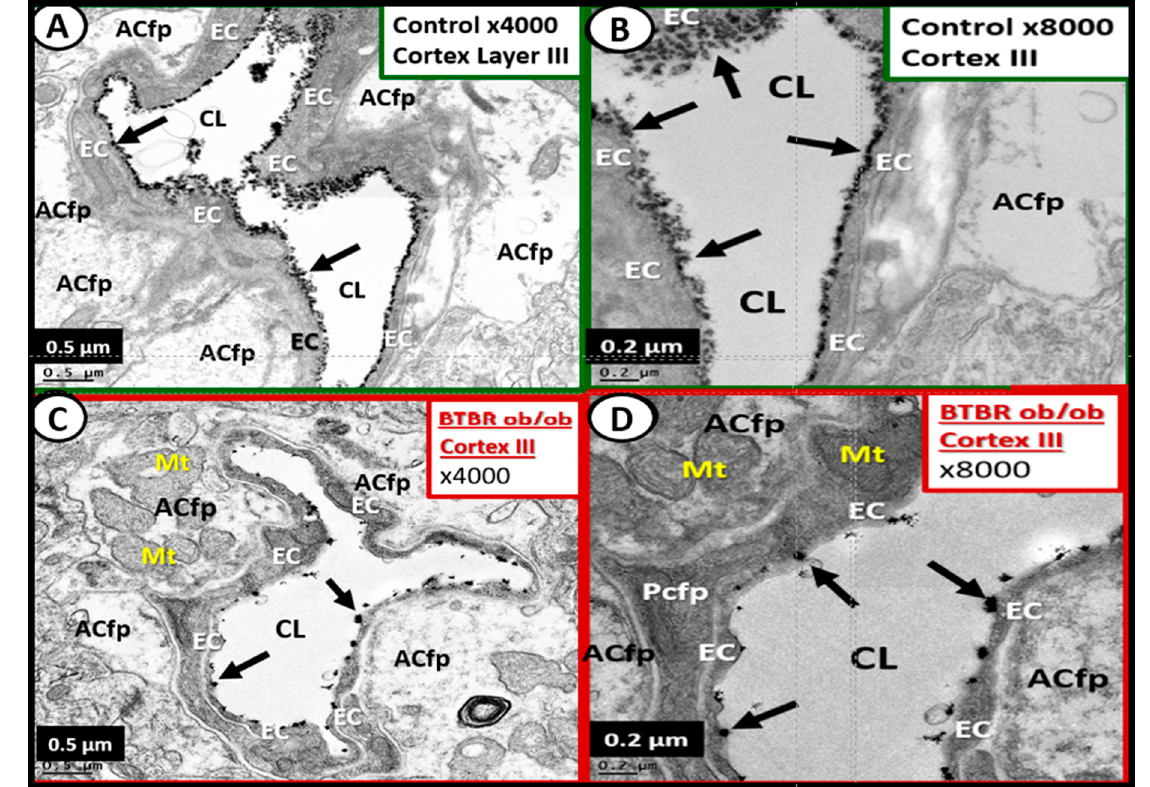
Figure 7. Lanthanum nitrate (LaN) staining of the endothelial glycocalyx (ecGCx) showing attenuation and loss in the diabetic obese BTBR ob/ob model: cortical Layer III at 20 weeks of age. Panels A and B demonstrate in the wild type control an intense electron dense LaN staining reflecting an intact continuous ecGCx or endothelial surface layer (arrows) of the brain endothelial cell(s) (BEC) at × 4000, × 8000; scale bars = 0.5, 0.2 µ m respectively. In addition, note the intact astrocyte foot processes (ACfp), pericyte foot processes (Pcfp), and intact mito-chondria (Mt). Panels C and D depict the attenuation, shedding, and/or loss of the continuous ecGCx (arrows) with clumping of remaining LaN positive ecGCx (arrows) at × 4000, × 8000; 0.5 and 0.2 µ m respectively in the BTBR ob/ob obese diabetic models. Furthermore, note the intact ACfp, Pcfp and intact Mt. Scale bars lower left corner of each panel and magnification in the upper right. CL = capillary neurovascular lumen; EC = endothelial